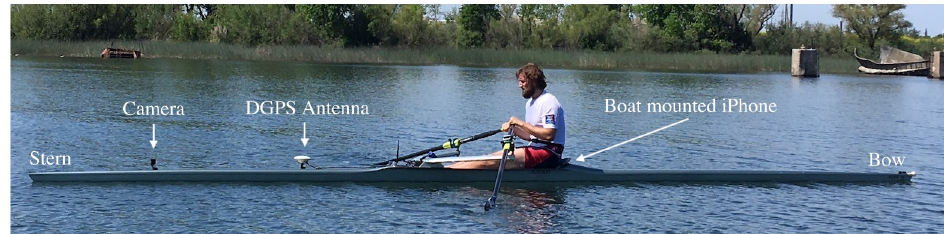
Fig 8. Sensor locations during elite trials. 2004 Hudson heavy-weight with the elite rower, annotated for experimental hardware. Note the DGPS antenna is clearly visible to the sky (above 15 degrees from horizontal in all directions it is with a clear view to the sky). The individual pictured has given written informed consent (as outlined in PLOS consent form) to publish these case